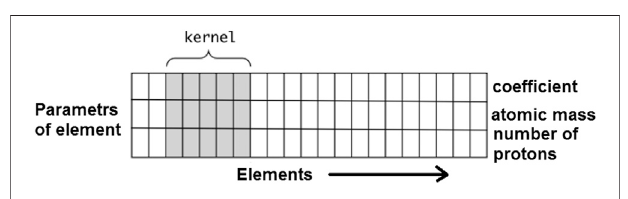
FIGURE 2 | One-dimensional convolution neuron.